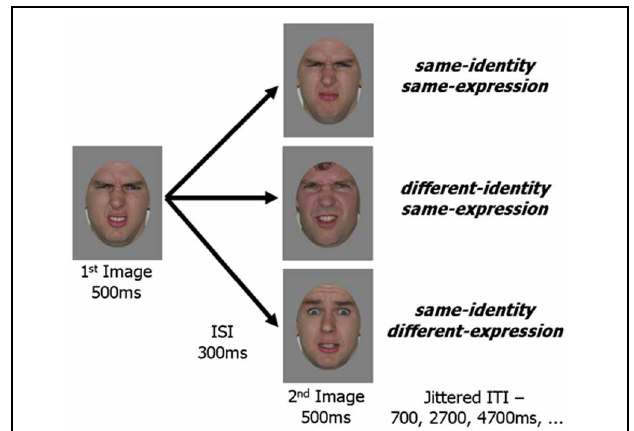
FIGURE 2 | Schematic representation of an experimental trial. In all three experimental conditions the first image was the same. The second image in the pair was either a new picture with the same identity and same expression as the first image, a picture of a different person with the same expression or a picture of the same person with a different expression. An image pair was presented within every TR (2s) and fixation trials were randomly intermixed with experimental